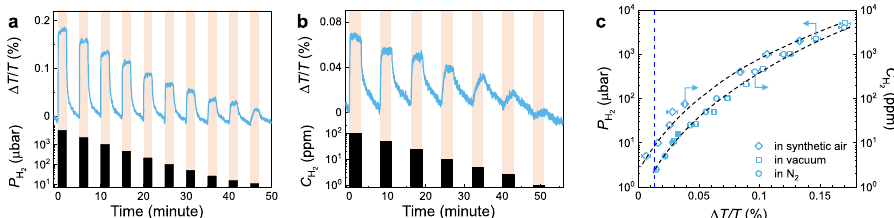
sensors to stepwise decreasing hydrogen pressure in 5 sensors with different 5